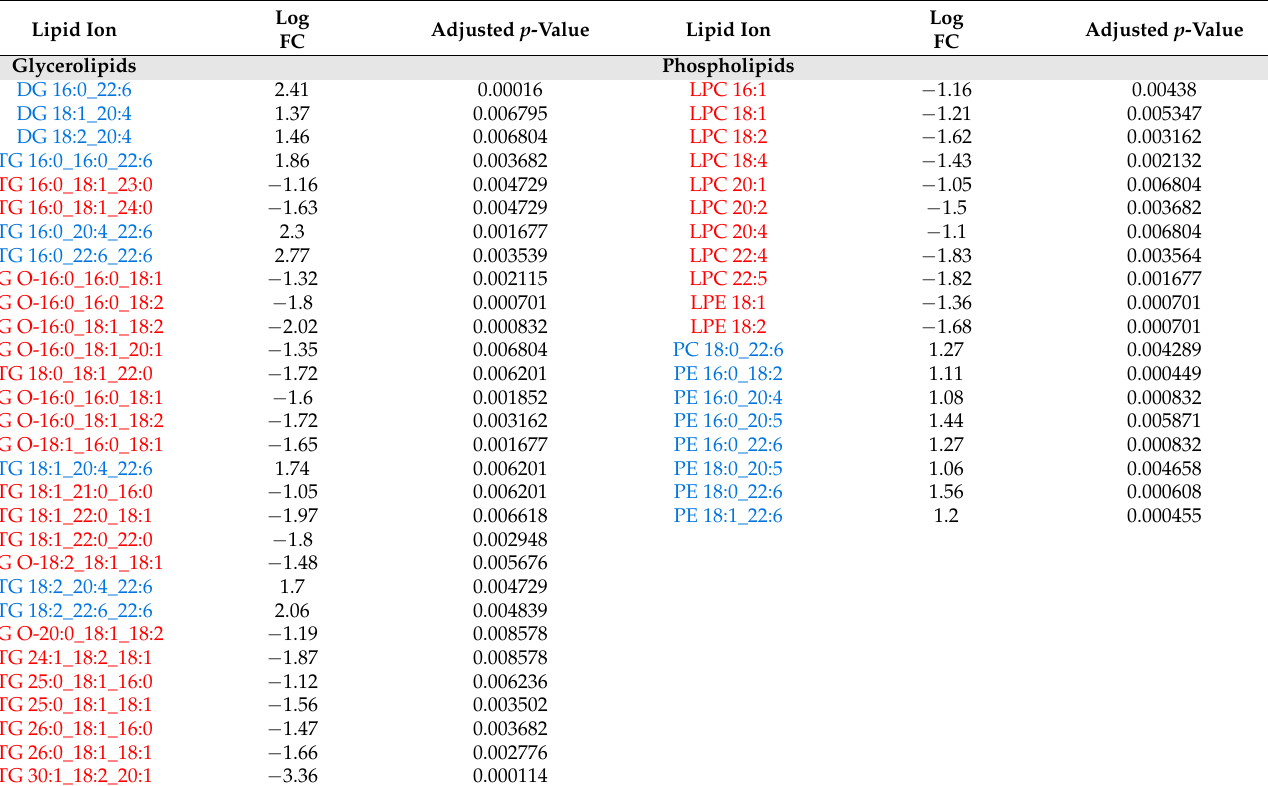
Table 3. Individual lipid molecules found at significantly different levels in PbA vs. Py. Ions elevated (dropped) in PbA are coloured in blue (red). Log2 fold-change and adjusted p -values are listed (i.e., moderated t -test and FDR correction). Ions are grouped into neutral lipids and phospholipids (located in the tables in a vertical fashion near each group of lipids) and sorted alphabetically within each